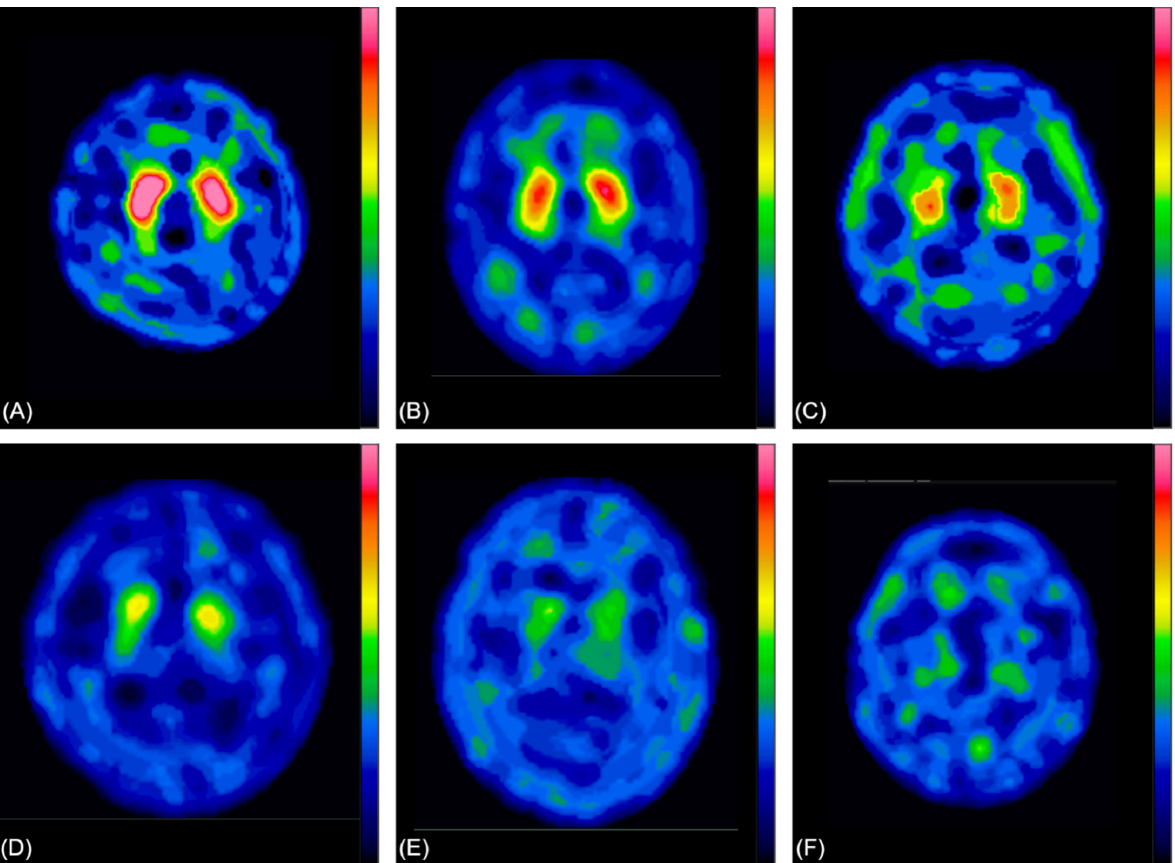
Figure 1. Functional images marked for Parkinson’s disease severity by clinicians. From the top left to the bottom right: categories 0–5 (total: 6 categories). ( A ) category 0, normal striatal uptake bilaterally; ( B ) category 1, normal caudate up- take with putamen uptake loss of >50% on one side and <50% on the other; ( C ) category 2, normal caudate uptake with putamen uptake loss of >50% bilaterally or reduced caudate and putamen uptake of approximately 50% bilaterally; ( D ) category 3, caudate uptake loss of <50% with no putamen uptake; ( E ) category 4, a condition between categories 3 and 5; ( F ) category 5, no striatal uptake bilaterally.